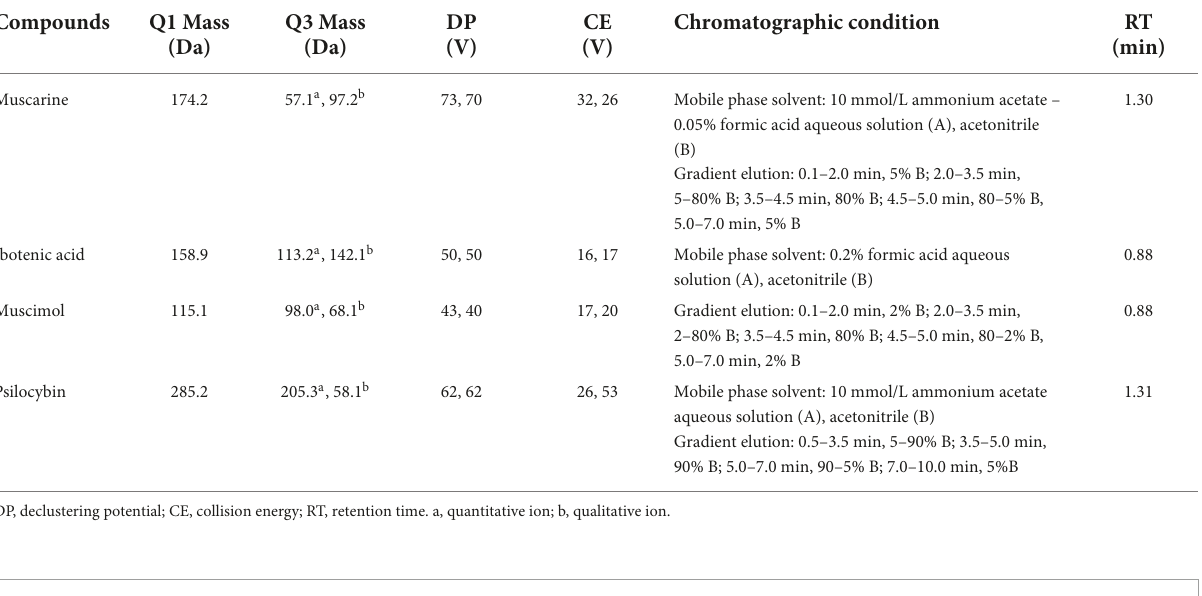
TABLE 1 Instrument parameters for the UPLC-MS/MS analyses.